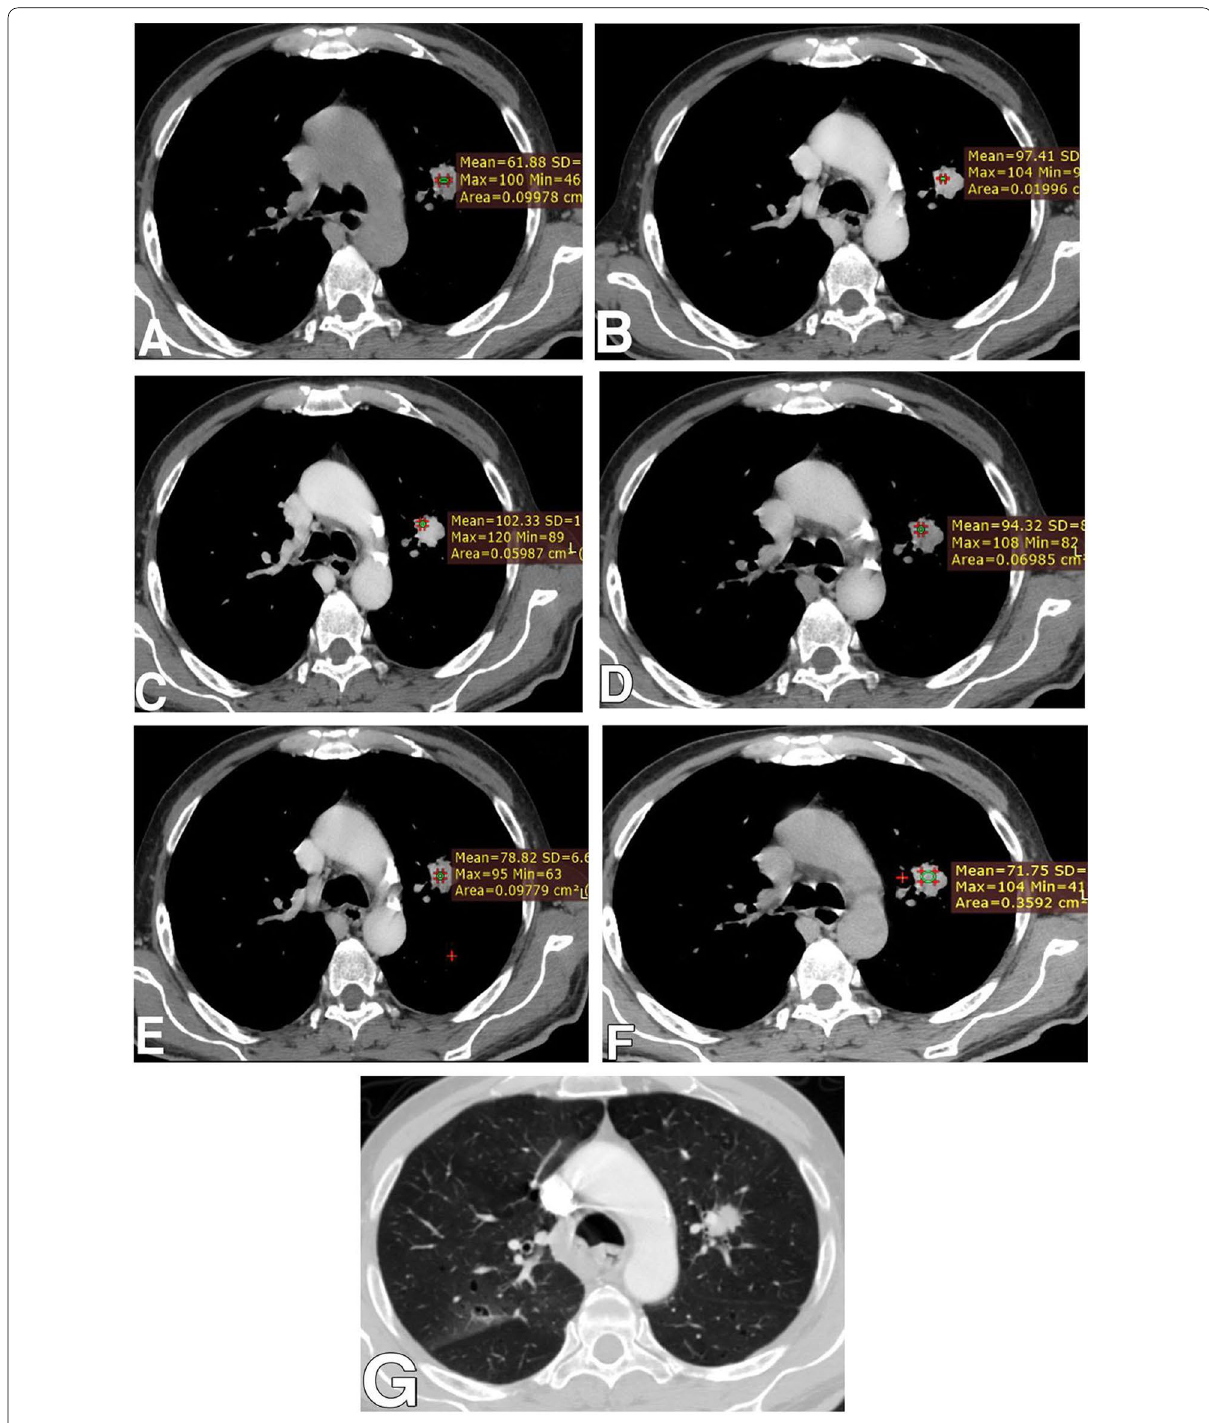
Fig. 1 Dynamic CE‑CT study A Pre contrast axial CT scan of the chest on mediastinal window, B–F contrast enhanced axial CT scans of the chest on mediastinal window obtained 1,2,3,4 &15 min respectively after contrast injection: All figures showed: Well defined pulmonary nodule with irregular speculated border in left upper lung lobe measured 2.5 cm shows mean pre contrast enhancement of 61 HU, mean peak enhancement (after 2 min) of 102 HU and net enhancement 41HU. G Axial CT scan of chest in pulmonary window showing the same pulmonary nodule with = irregular speculated borders in left upper lung lobe. Pathological diagnosis: Moderately differentiated